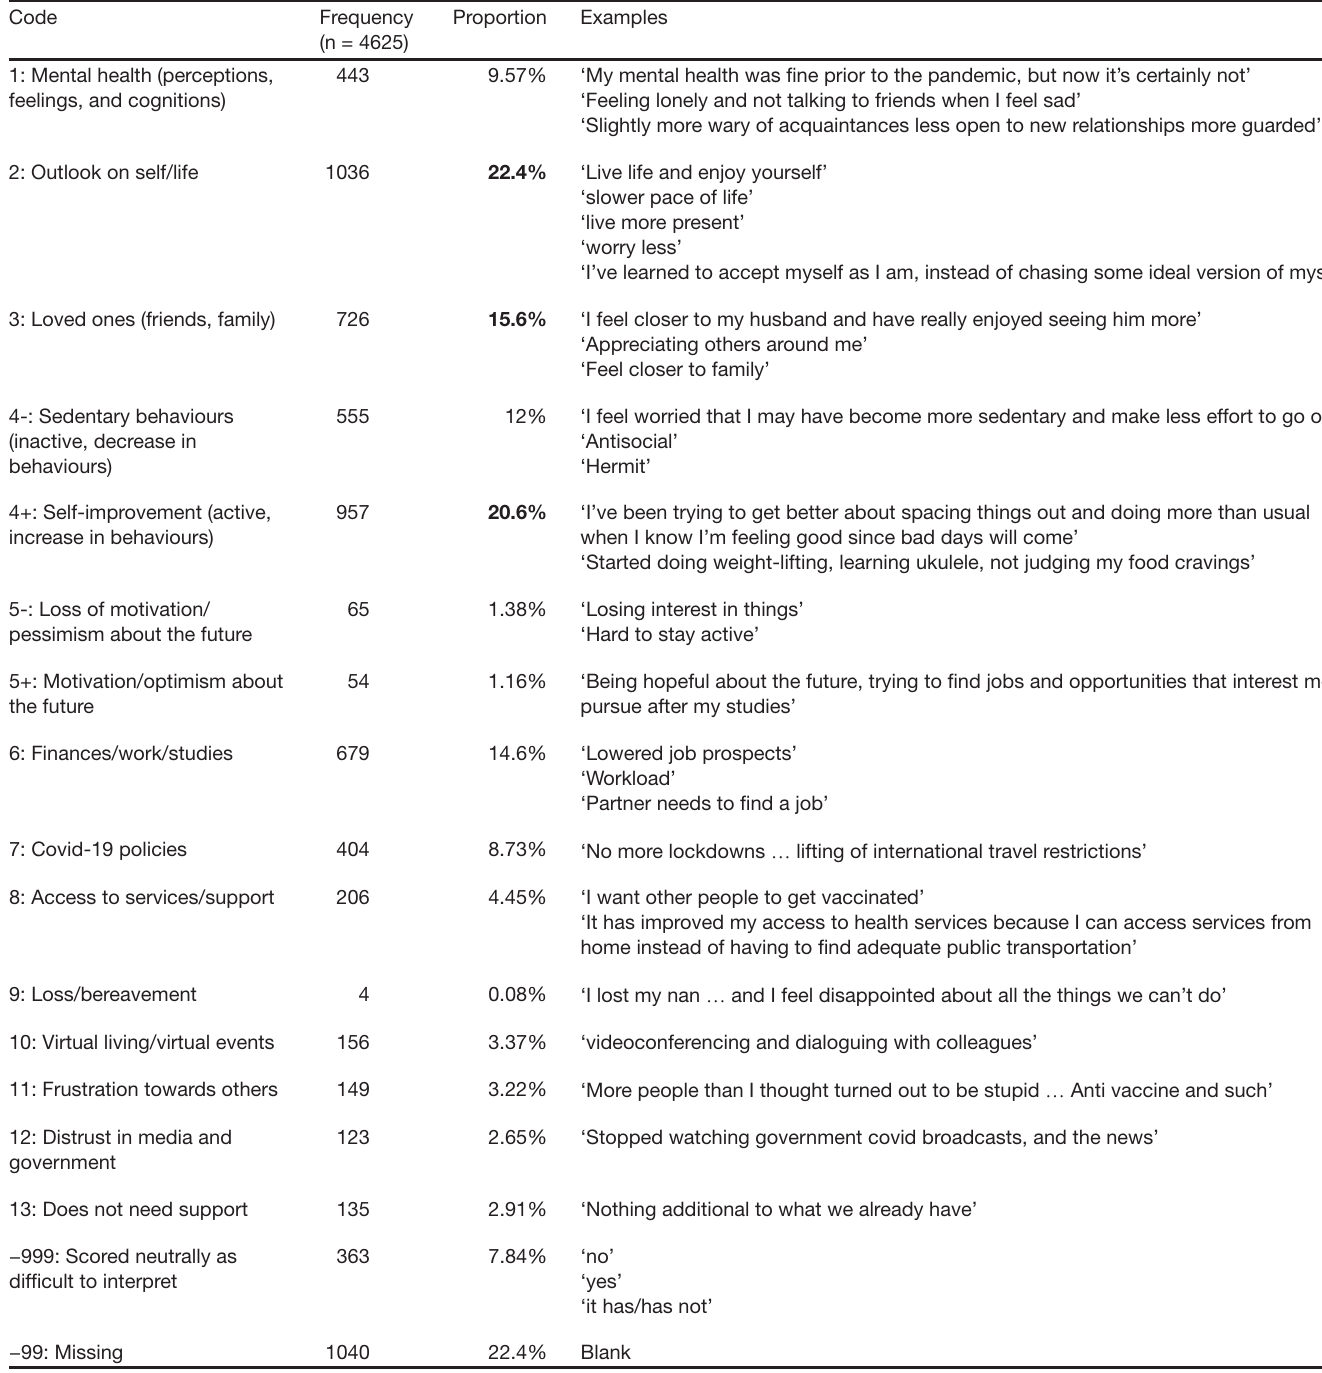
Table 3. Example and prevalence of codes across five questions from 925 participants (total 4625 responses)